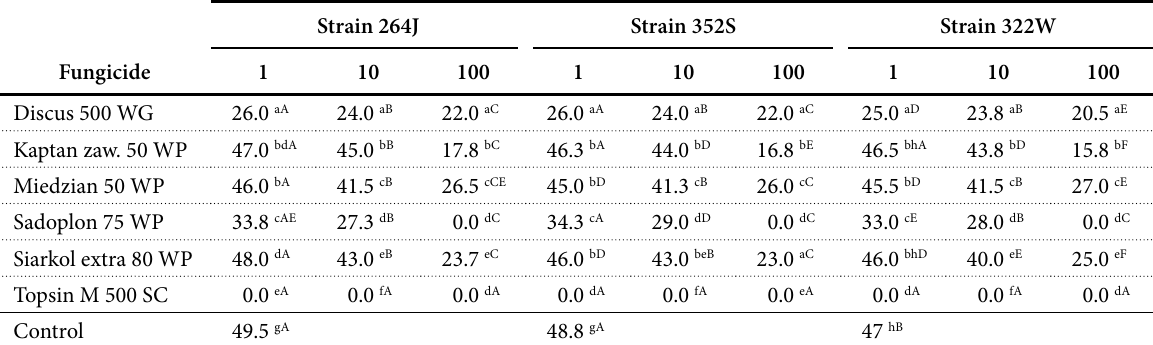
Tab. 2 Effect of fungicides on mycelial growth of Diaporthe eres strains after 4 days of cultivation.